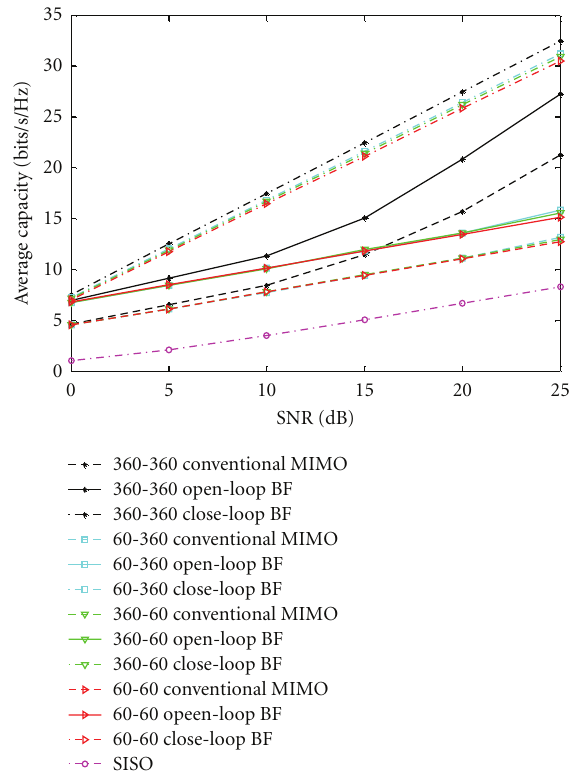
Figure 8: Average capacity (bits/s/Hz) versus SNR (dB) for 4 conditions of angle spread, Δ t = Δ r = 0 . 5.